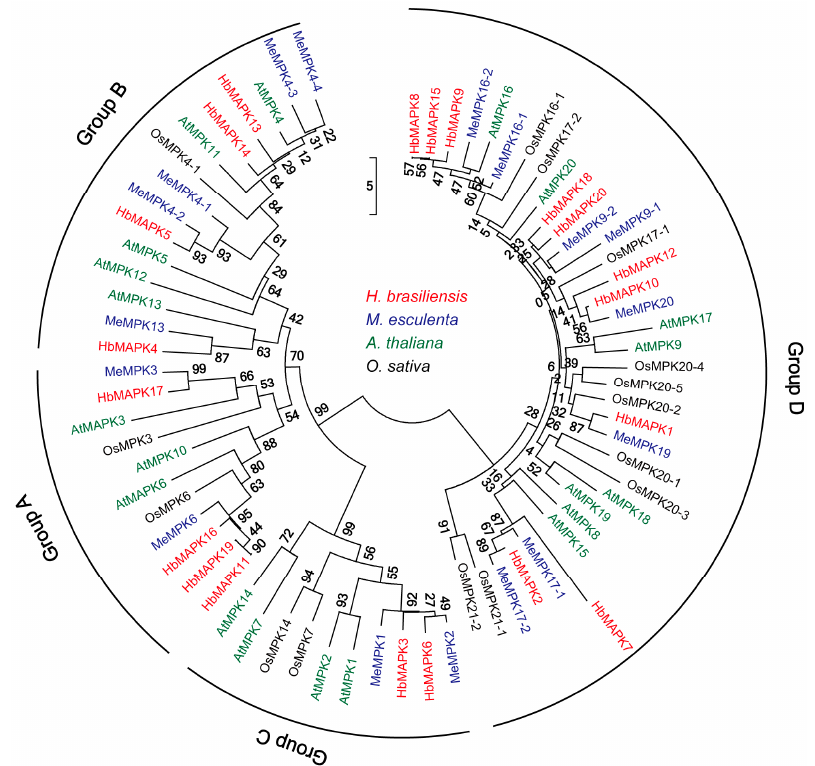
Figure 5. Phylogenetic tree of the MPK family in Arabidopsis thaliana , Oryza sativa , Manihot esculenta , and Hevea brasiliensis . The phylogenetic tree was constructed by ClustalX 2.0 and MEGA5.0 software using the neighbour-joining (NJ) method and 1000 bootstrap replicates. The names of the MPKs from the four species are shown in different colours. Four distinct clades (groups A–D) are highlighted. The vertical bar indicates evolutionary distance.